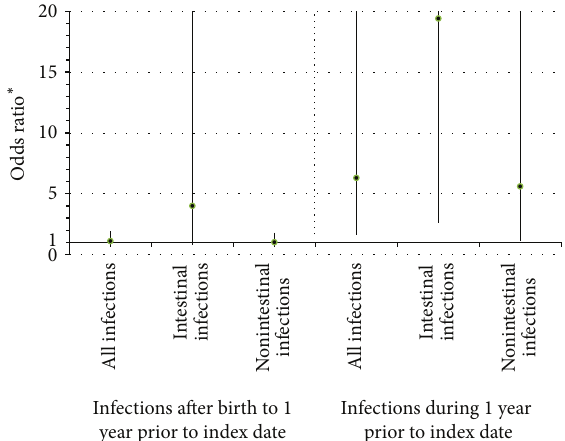
Figure 1: Odds ratios for hospitalized infections comparing Crohn’s disease cases with controls. ∗ Compared with controls using condi- tional logistic regression accounting for the matching factors: age and duration of membership as well as sex and race. Hospitalized the principal diagnosis code position. Intestinal infections included ICD-9-CM codes 001-009 and 567. The index date was defined as the date of the case’s diagnosis for both cases and matched